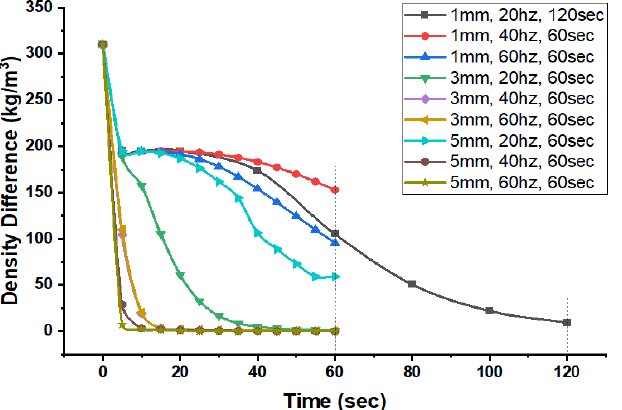
Figure 17. Overall comparison of mixing efficiency of RAM.